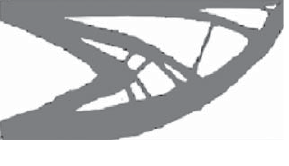
Fig. 4. Optimized